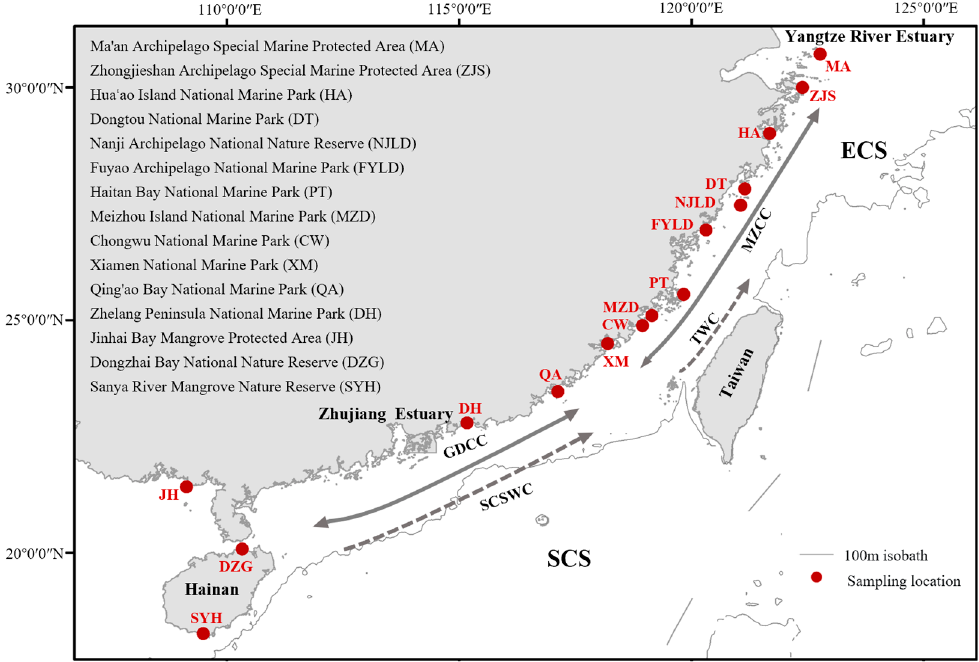
Figure 1. Sampling locations and ocean currents schematic in the studied area. TWC, Taiwan Warm Current; SCSWC, South China Sea Warm Current; MZCC, the coastal currents of Zhejiang and Fujian; GDCC, Guangdong coastal current. The direction of MZCC and GDCC varies seasonally, from south to north in summer and vice versa in winter [27], which is indicated by the solid line with bidirectional arrows in the figure.